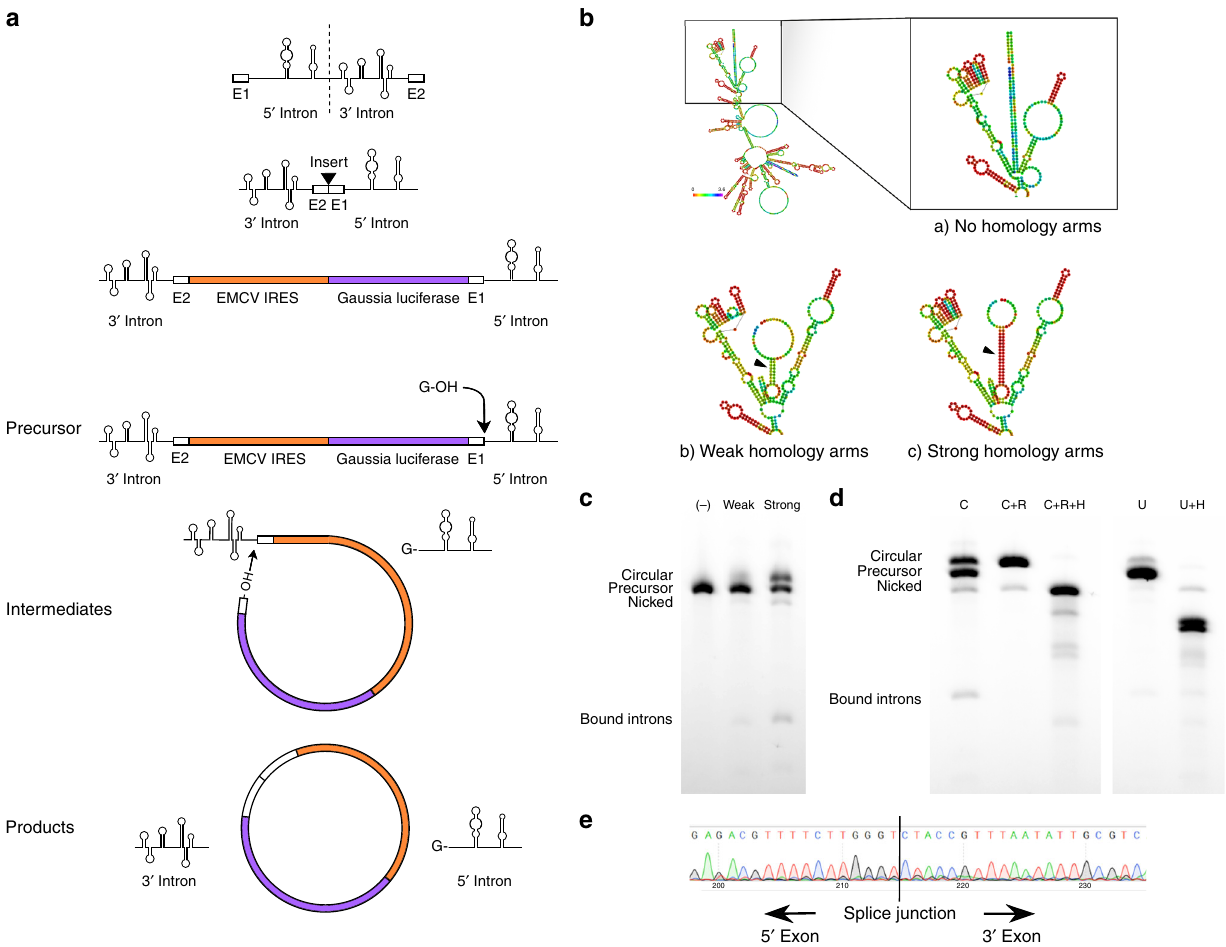
Fig. 1 Permuted intron-exon splicing and addition of homology arms. a Schematic diagram showing permuted intron-exon construct design and mechanism of splicing. The group I catalytic intron of the T4 phage Td gene is bisected in such a way to preserve structural elements critical for ribozyme folding. Exon fragment 2 is then ligated upstream of exon fragment 1, and a coding region roughly 1.1 kb in length is inserted between the exon-exon junction. During splicing, the 3 ′ hydroxyl group of a guanosine nucleotide engages in a transesteri fi cation reaction at the 5 ′ splice site. The 5 ′ intron half is excised, and the freed hydroxyl group at the end of the intermediate engages in a second transesteri fi cation at the 3 ′ splice site, resulting in circularization of the intervening region and excision of the 3 ′ intron. b RNAFold predictions of precursor RNA secondary structure for homology arm design. Colors denote base pairing probability, with red indicating higher probability. Without homology arms, no base pairing is predicted to occur between the ends of the precursor molecule. c Agarose gel demonstrating the effect of homology arms on splicing. Putative circRNA runs at a higher molecular weight than heavier precursor RNA, as indicated. ( − ): no homology arms. Weak: weak homology arms, 9 nt. Strong: strong homology arms, 19 nt. d Agarose gel con fi rmation of precursor RNA circularization. C: precursor RNA (with strong homology arms) subjected to circularization conditions. C + R: Lane C, digested with RNase R. C + R + H: Lane C + R, digested with oligonucleotide-guided RNase H. U: precursor RNA not subjected to circularization conditions. U + H: Lane U, digested with oligonucleotide-guided RNase H. e Sanger sequencing output of RT-PCR across the splice junction of the sample depicted in lane C + R from ( d